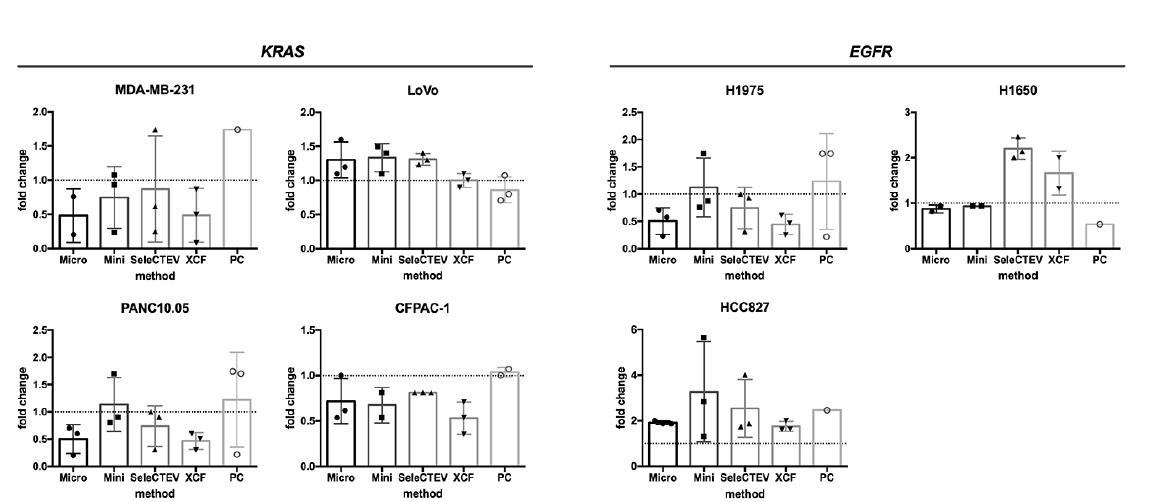
Figure 4. Mutational analyses of EGFR and KRAS genes in CCM-derived EV-DNA by TaqMan. Comparison of the quantity of detected mutated DNA in EV-DNA versus gDNA samples by TaqMan. The 2 − ∆∆ CT method was used as a quantification strategy to assess the fold difference in mutated DNA in EV-DNA in relation to gDNA. This analysis could not be applied to SW480 EV-DNA as the WT KRAS gene was not amplifiable.